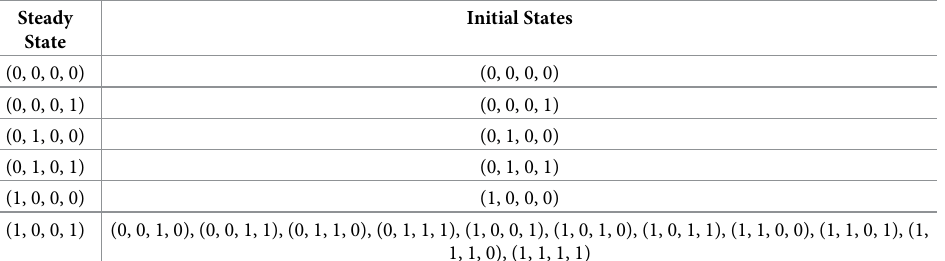
Table 1. Mapping of the initial states to their corresponding steady state. By mapping states to themselves, they cre- ate a steady state for the network that can not be accessed by any other state. Note, that in principle, initial states can converge towards multiple different steady states. This behavior is captured easily by just adding these states to all of the corresponding steady state lists. Steady